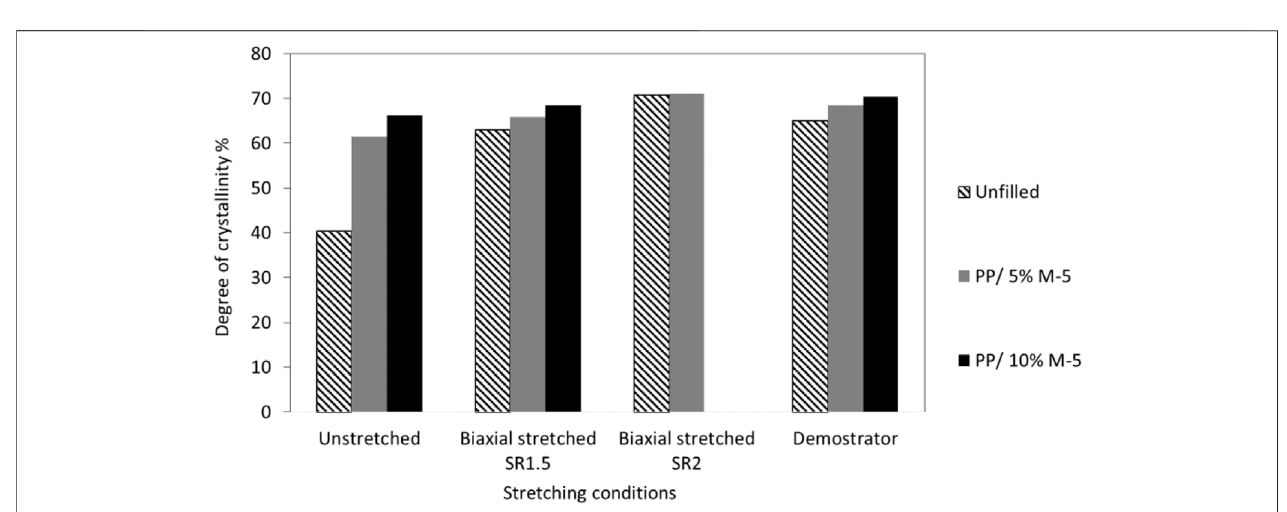
FIGURE 1 | Effect of GNP content and the biaxial stretching deformation on Xc% of un fi lled PP, PP/GNP composites and the demonstrator parts.